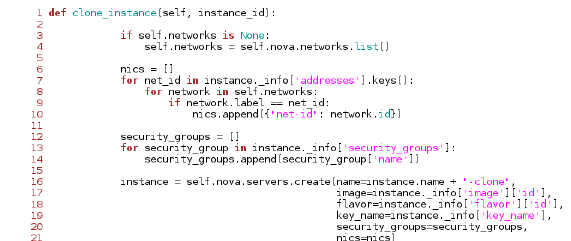
Figure 5: The main functions of the Agent compo- nent